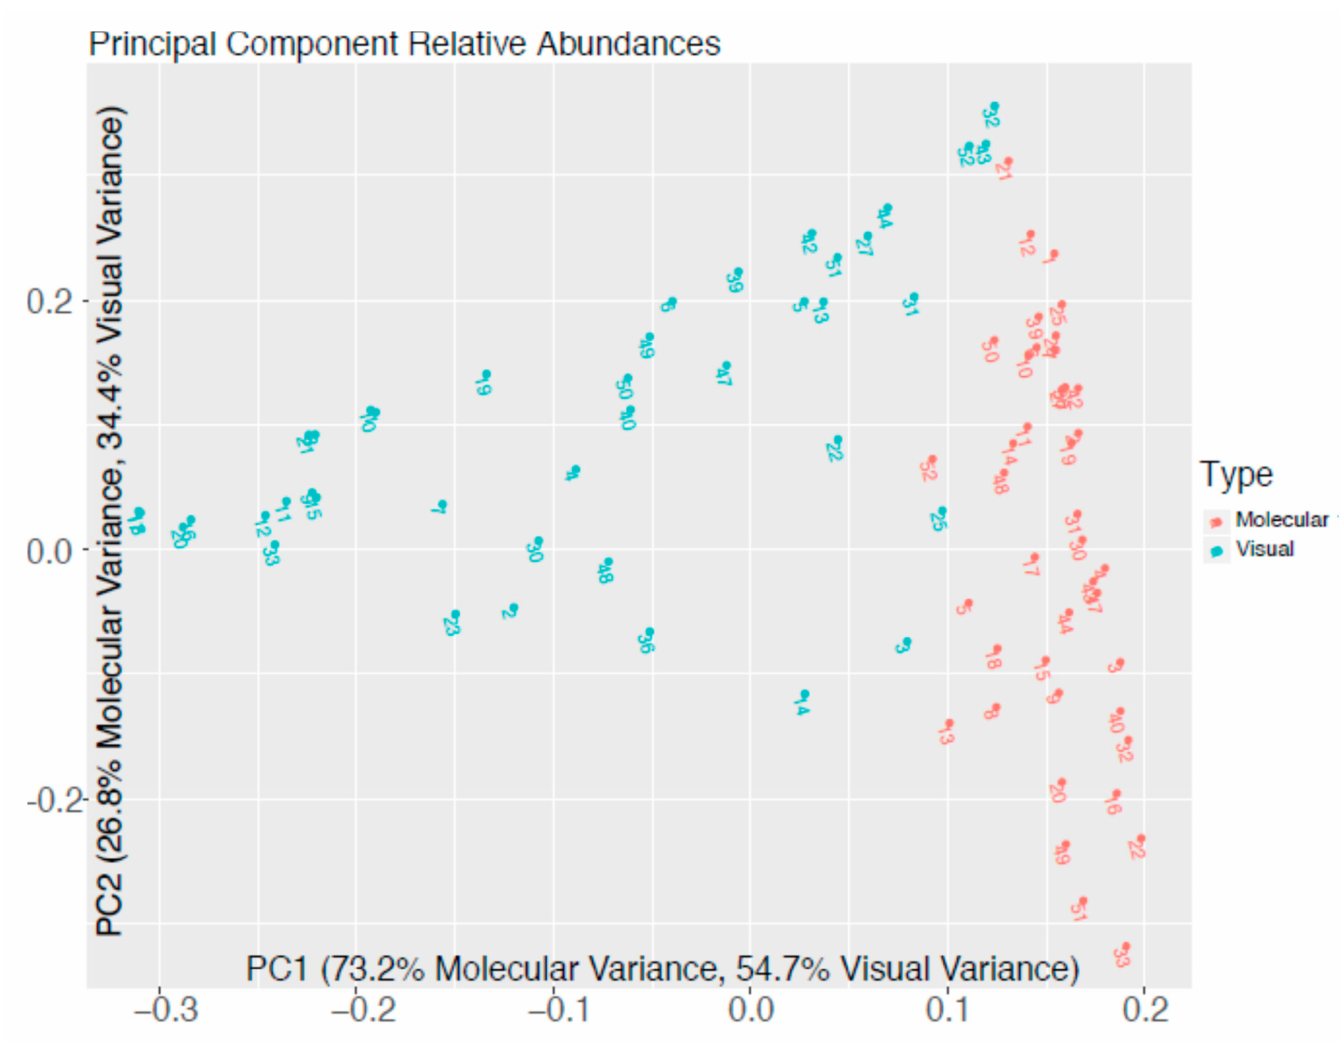
Figure 5. Principal Component Analysis of Relative Taxonomic Abundance Comparing Visual and Molecular